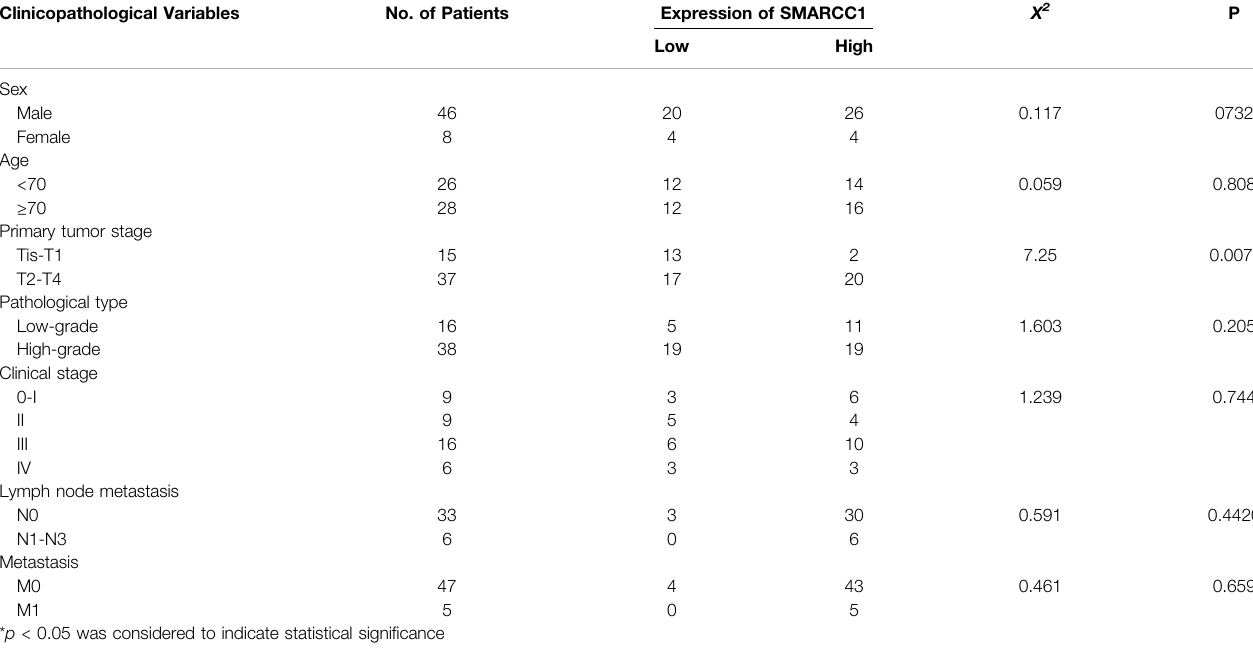
TABLE 1 | High expression levels of SMARCC1 were correlated with clinicopathological features in BC. Clinicopathological